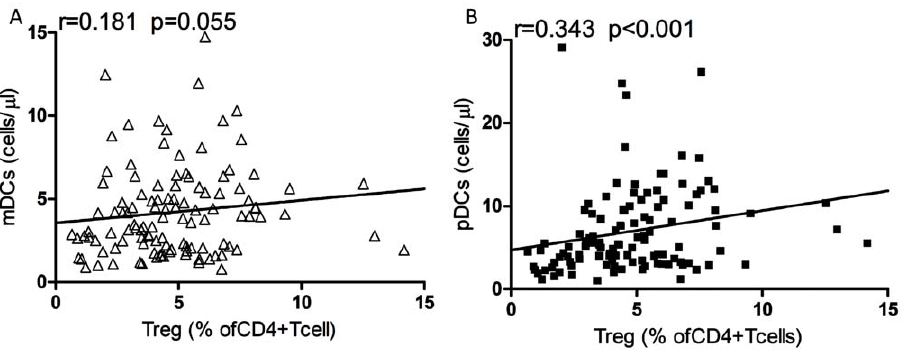
Figure 4. The association of DC subsets with Tregs percentage. (A) Correlation between mDCs counts and Tregs percentage during ART. (B) Correlation between pDCs counts and Tregs percentage during ART.